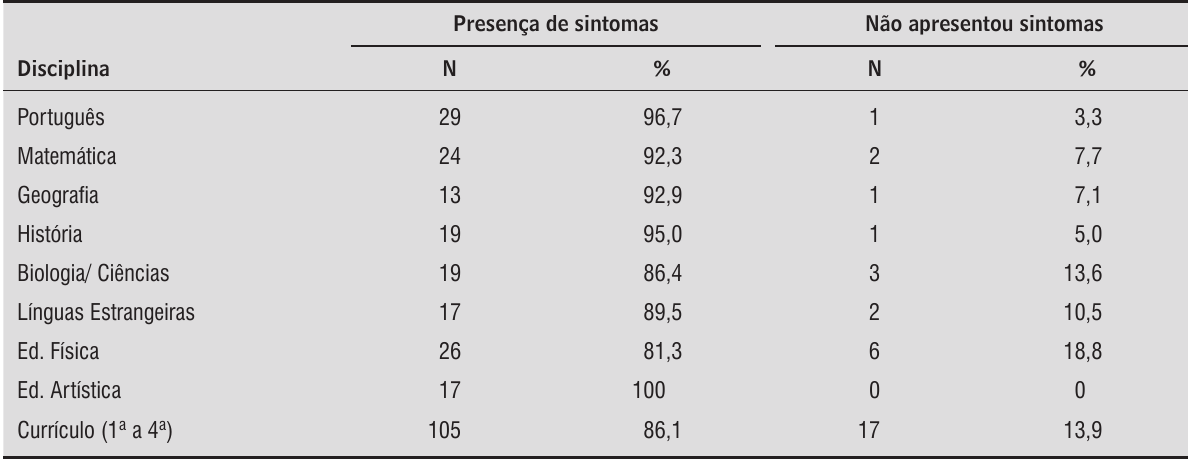
Tabela 3 - Prevalência de sintomas osteomusculares em relação à disciplina ministrada pelos